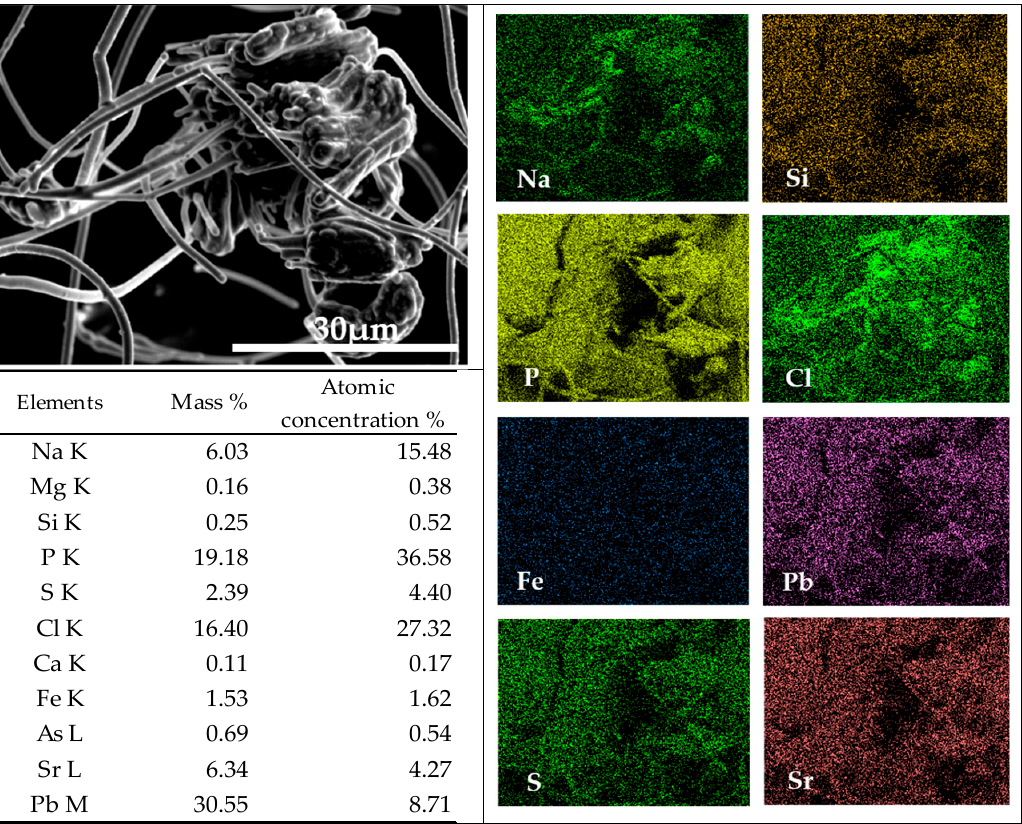
Figure 7. Scanning electron microscopy (SEM) equipped with energy dispersive analyses with an acceleration voltage of 15 kV of the oily soils collected from the Atake seashore on 2 May 2017, indicating a rich presence of Na, P, S, Cl, Fe, Sr, and Pb in the filamentous bacterial colony.